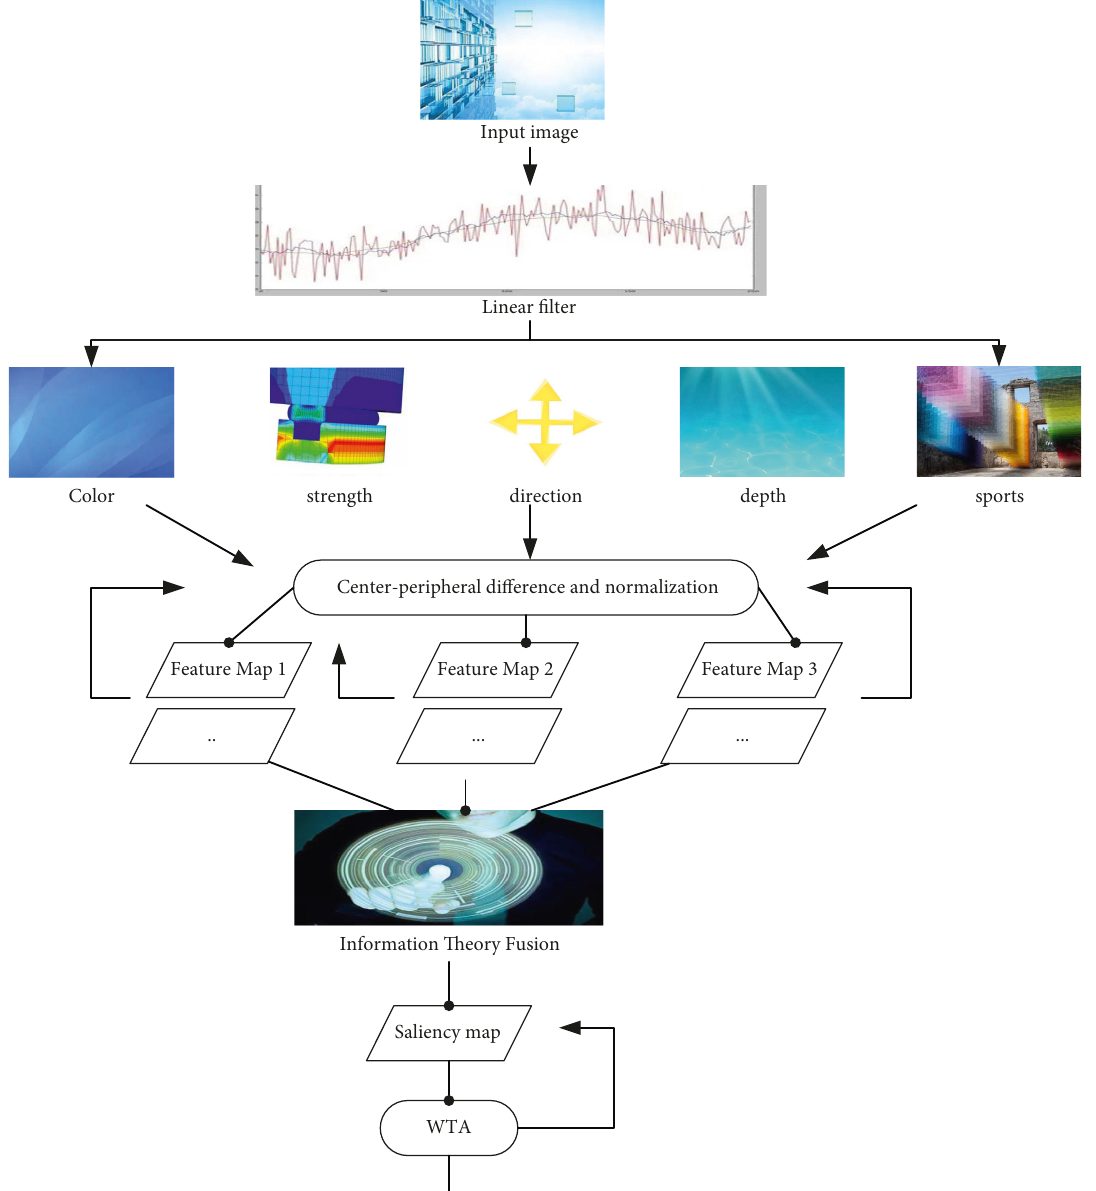
Figure 2: Visual attention mechanism